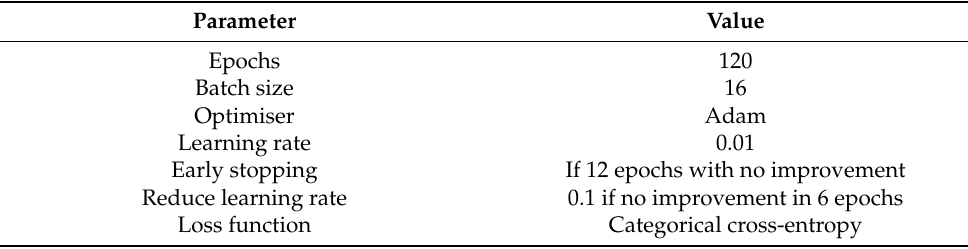
Table 3. Parameters for training the ANNS.